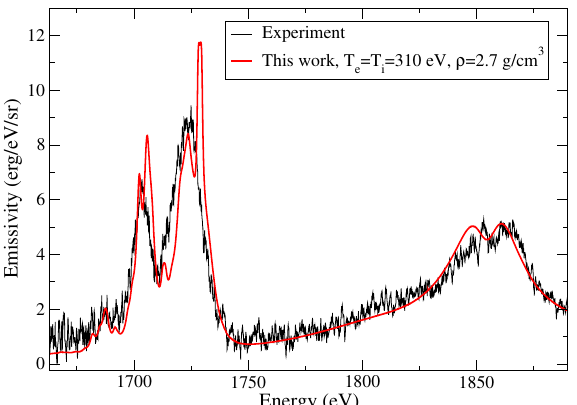
Figure 6. Measured emission of aluminum “buried layers” heated by an ultra-short laser [34] (emissive volume: 400 µ m 2 × 0.5 µ m, duration: 3 ps) compared to our SCO-RCG prediction at T = 310 eV and solid density ( ρ 0 = 2.7 g/cm 3